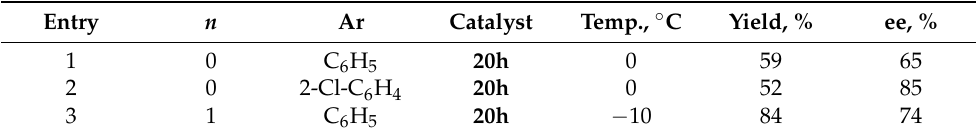
Table 12. Effect of crown ethers in the Darzens condensation of 2-chloroindanone ( 81 , n = 0), and of 2-chlorotetralone ( 81 , n = 1).